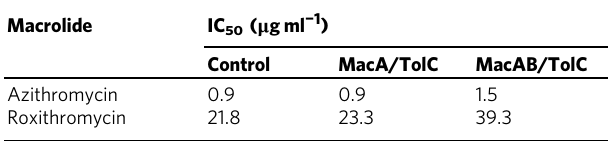
Table 2 IC 50 values determined in the growth experiments in Fig. 1b with E. coli expressing A. baumannii Mac and TolC